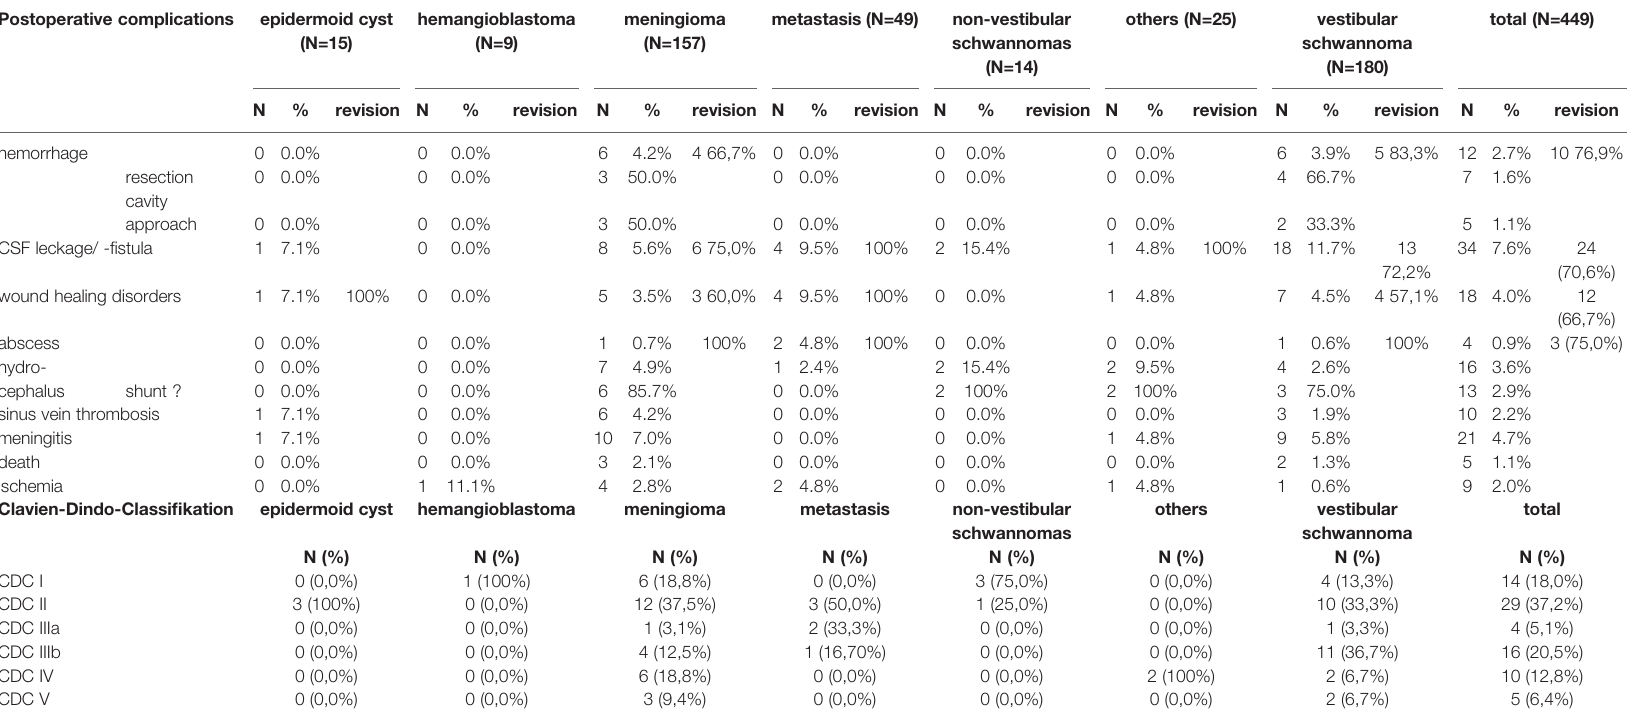
TABLE 3 | Postoperative complications and Clavien – Dindo Classi fi cation